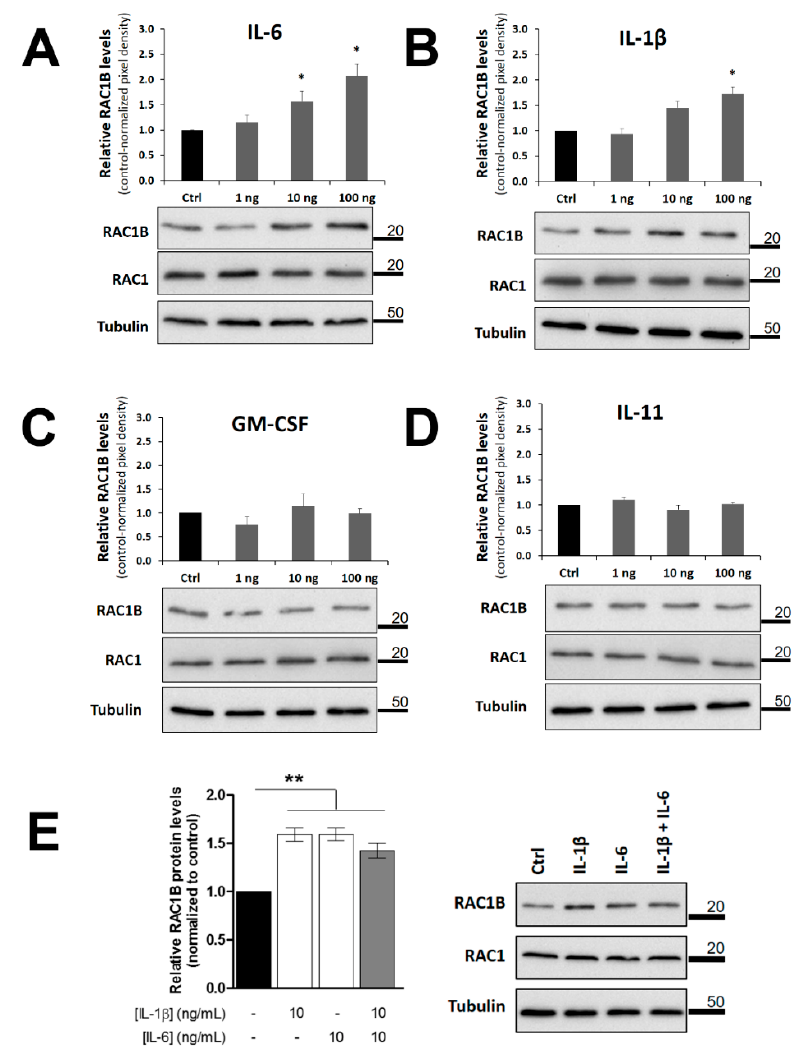
Figure 5. RAC1B protein levels in polarized Caco-2 cells after addition of purified candidate cytokines. Polarized Caco-2 cells were grown on filter inserts and then the indicated ( A – D ) purified cytokines or ( E ) cytokine combinations were added to the basolateral growth medium. Cells were lysed after 48 h, proteins analysed by SDS-PAGE and the indicated proteins detected by WB. Detection of the α -tubulin protein served as a loading control. Data are shown as fold change in RAC1B protein levels relative to control (addition of antibody solvent PBS to the medium) and represent mean values ± SEM, of at least 3 independent experiments. Statistical analysis was carried out with a one-way ANOVA test (F = 39.04, p < 0.001), followed by Tukey’s post hoc tests; * or ** significantly different from the corresponding control (PBS) with p < 0.05 or p < 0.01,